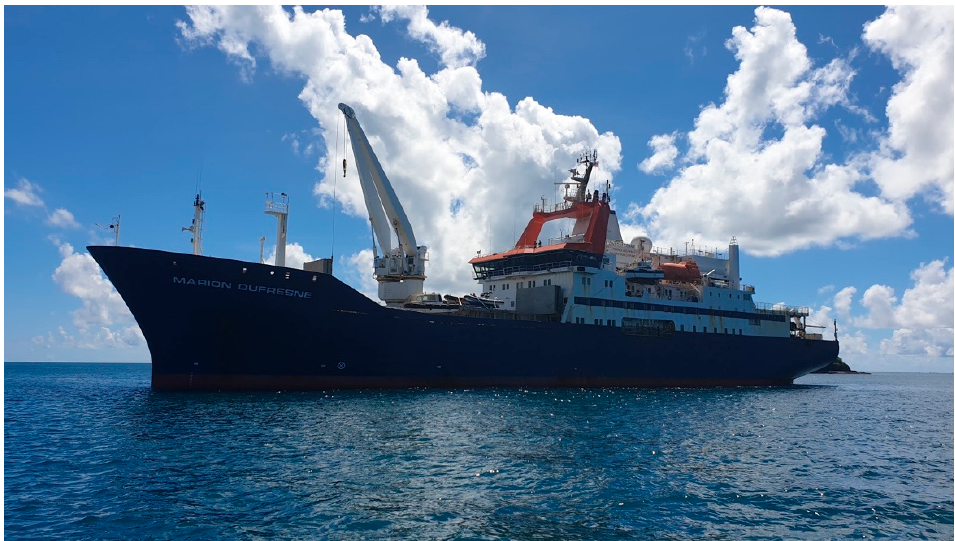
Figure 27. Picture of the RV Marion Dufresne anchored at Mayotte during TAAF’s Eparses Island rotation in April 2019. Source: Olivier Bousquet